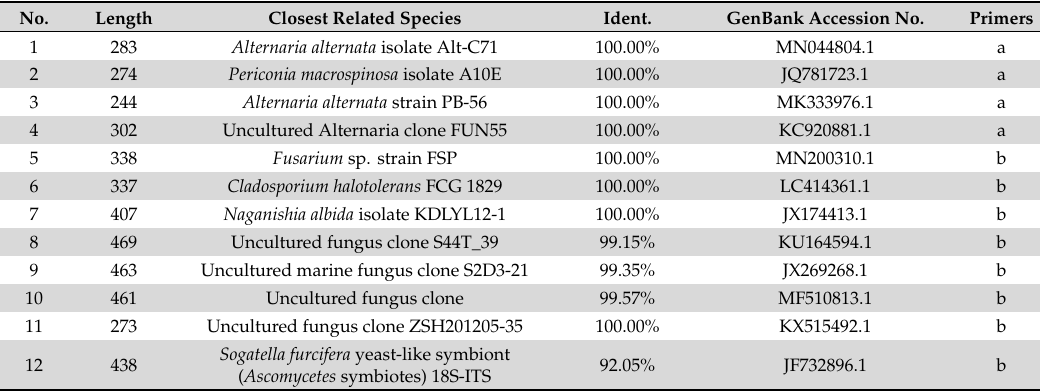
Table 2. BLAST and sequence analysis of selected DGGE